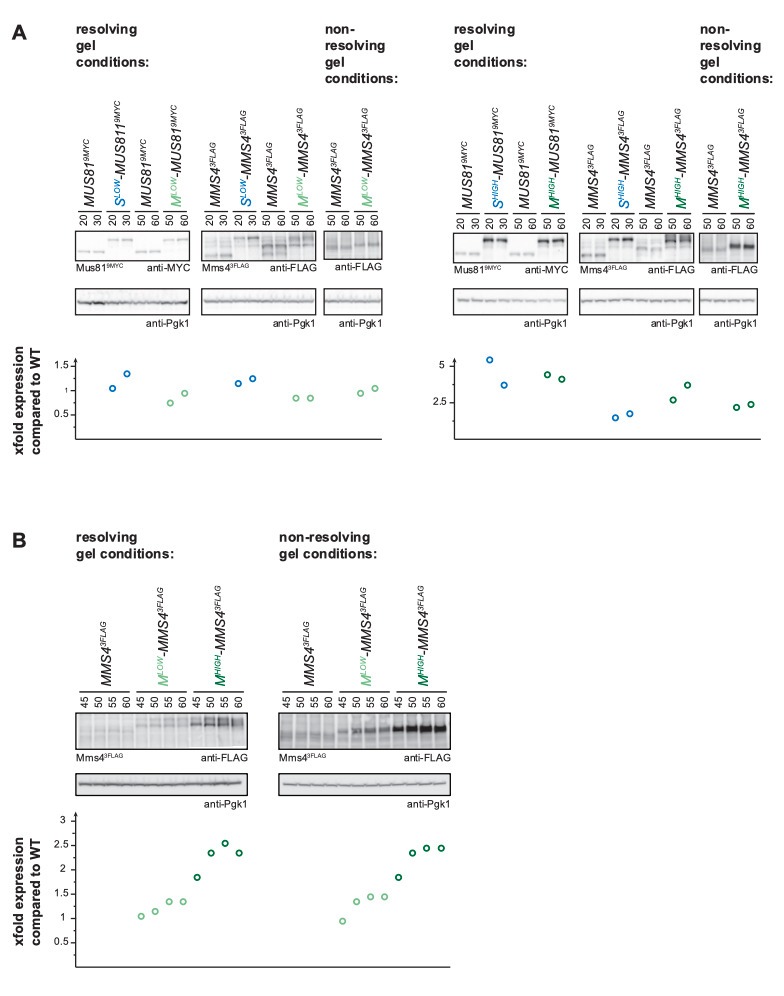
Quantification of Mus81 and Mms4 levels after resolving and non-resolving gel running conditions.Expression levels were quantified using Image-J and signals at the individual timepoints were divided by the corresponding Pgk1 sample to normalize to overall protein levels. Normalized protein levels were compared to WT expression at the corresponding timepoint (fold difference) and the resulting fold difference is depicted in the graphs below the western blots. For the mitotic Mms4 samples (Mlow-Mms4 and Mhigh-Mms4) the analysis was done both after resolving (4-12% gel, 90min) and after non-resolving (12% gel, 25 min) gel conditions to show the validity of quantifying phosphorylated Mms4 signals. The Mus81 and S phase Mms4 samples were run with resolving gel conditions only. A, Quantification of peak expression levels from Figure 2—figure supplement 1, extended by an analysis with non-resolving gel conditions for the mitotic Mms4 samples. B, Quantification of peak expression levels from samples of the experiment shown in Figure 2C with resolving and non-resolving gel conditions.